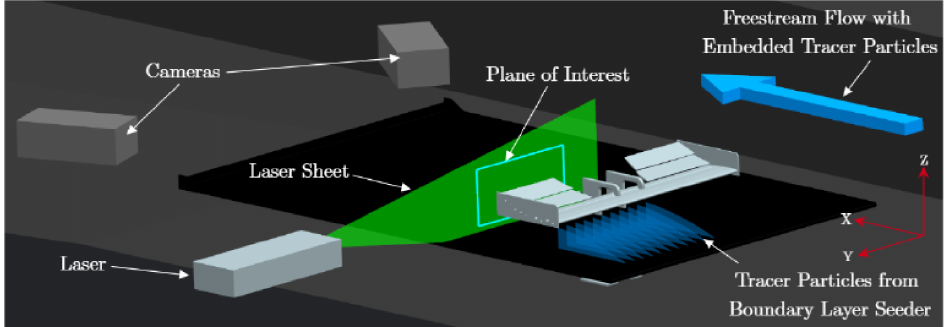
Figure 3. PIV setup used to capture cross-plane velocity